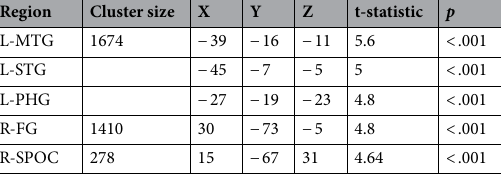
Table 1. Searchlight result cluster sizes (voxels), peak coordinates (Talairach) and